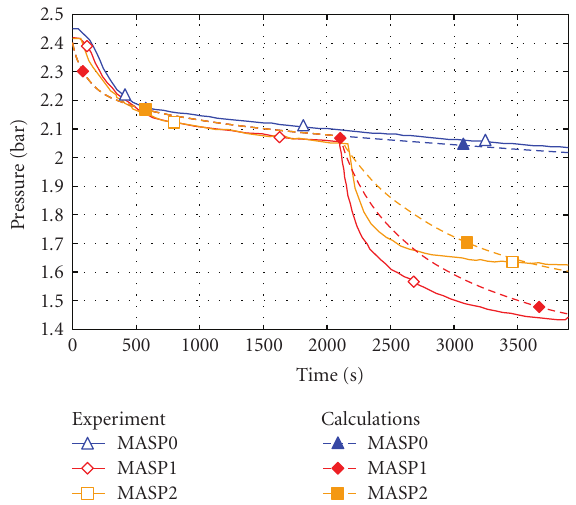
Figure 11: Comparison of pressure evolutions calculated from base case and calculated without external structures, MASP0. Figure 12: Pressure evolutions calculated with decreased junction area behind lower